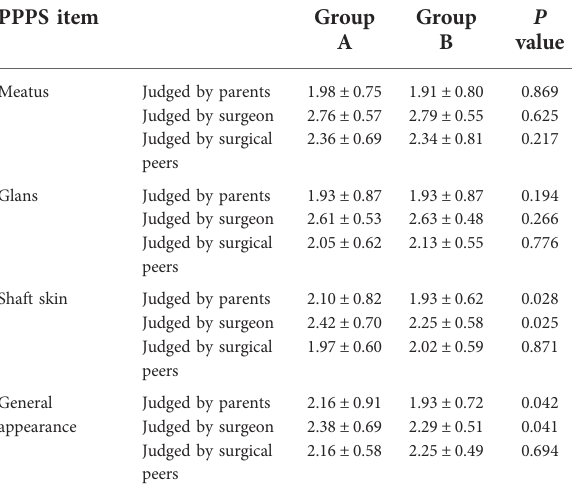
TABLE 4 Comparison of the two groups on urinary function, as judged by parents.